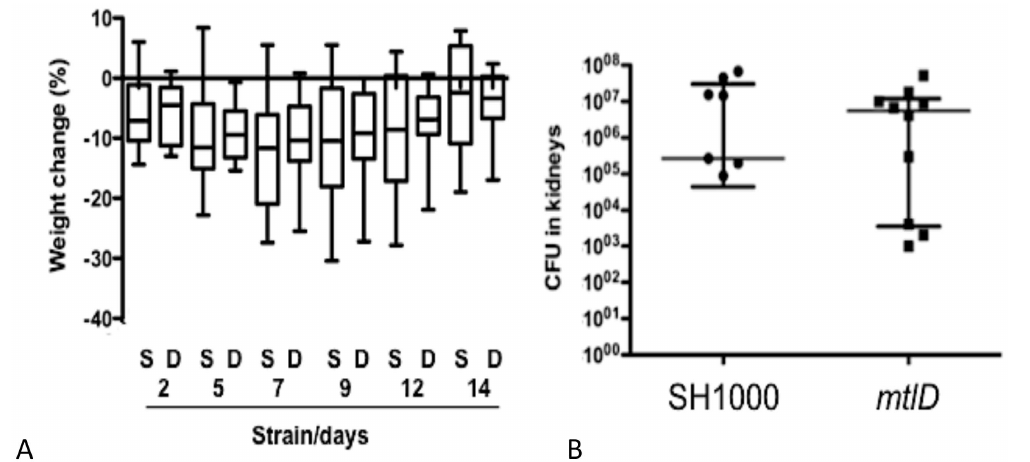
Figure 8. Virulence of mtlD in a murine infection. (A) Effect of WT SH1000 or Liv1023 (SH1000 mtlD::tet ) on percentage change in weight of infected mice. There were no significant differences using Dunn’s test. (B) Effect of mutations of mtlD on cfu of S. aureu s SH1000 in kidneys of infected mice. There were no significant differences using the Mann Whitney Test.